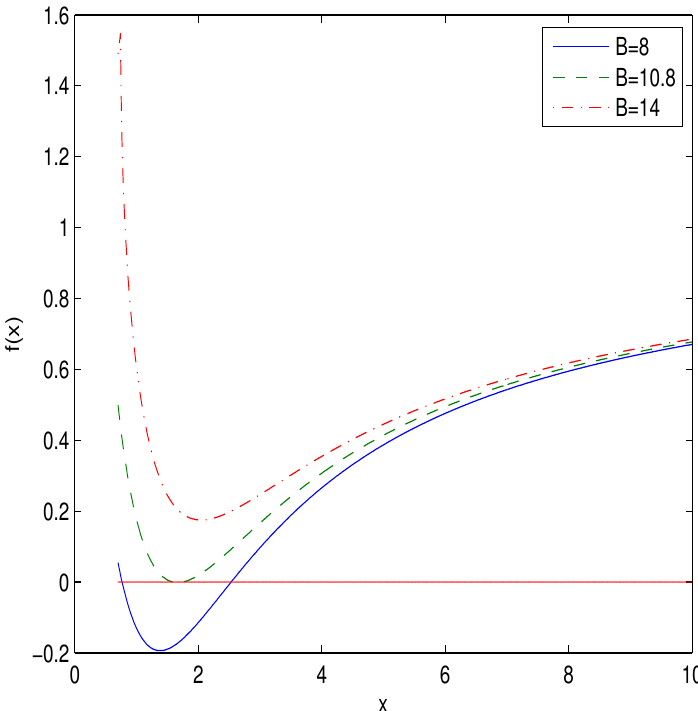
Figure 1. The plot of the function f ( x ) for A = 7, C =